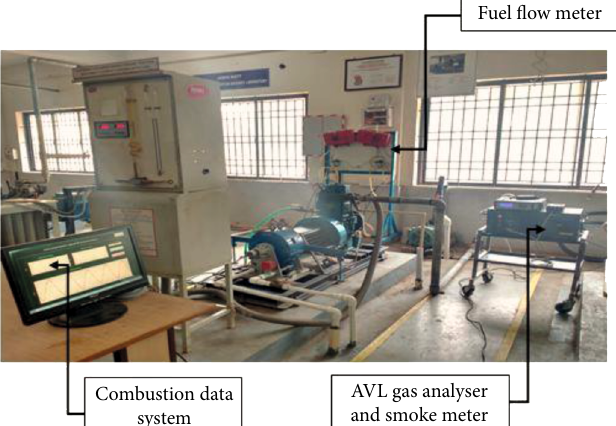
Figure 6: Photo of experimental test